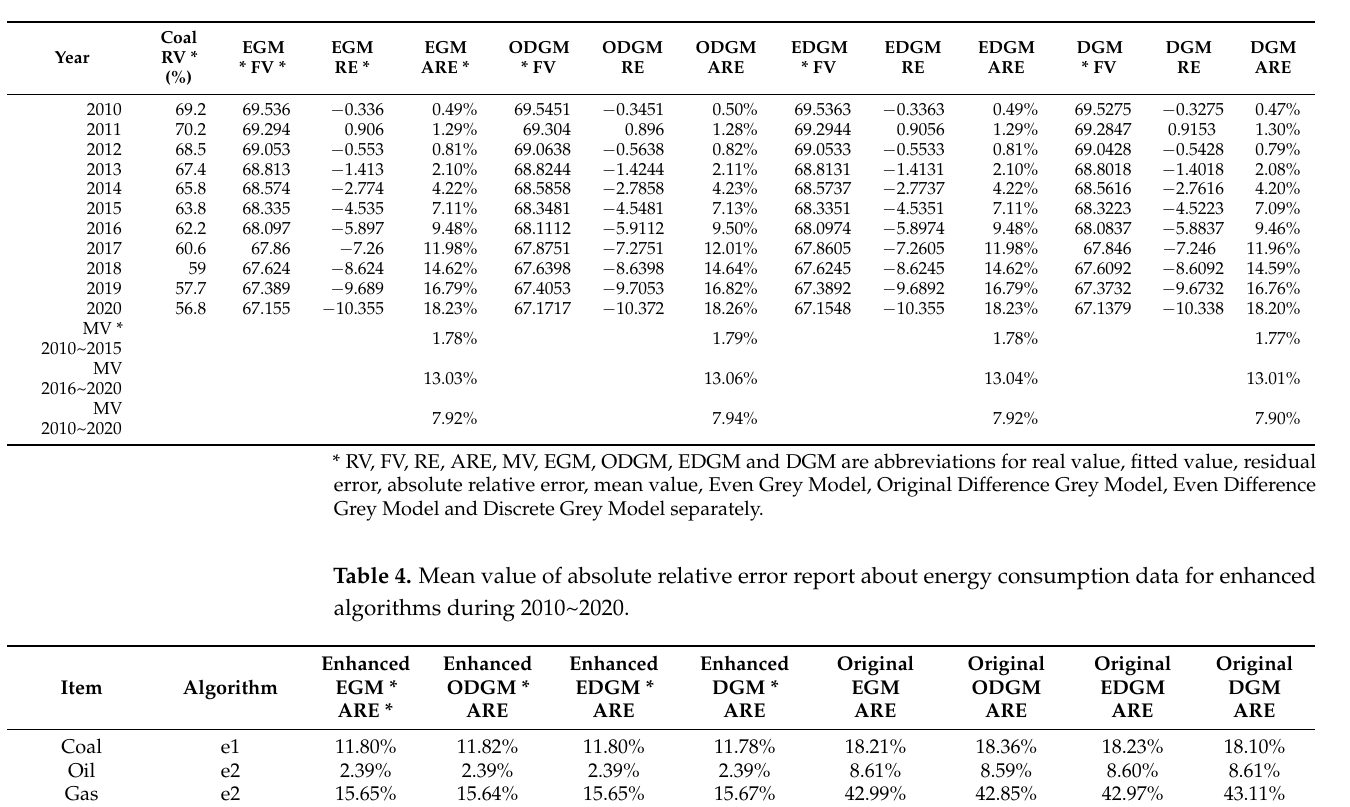
Table 3. Relative error report about coal consumption percentage for e1.